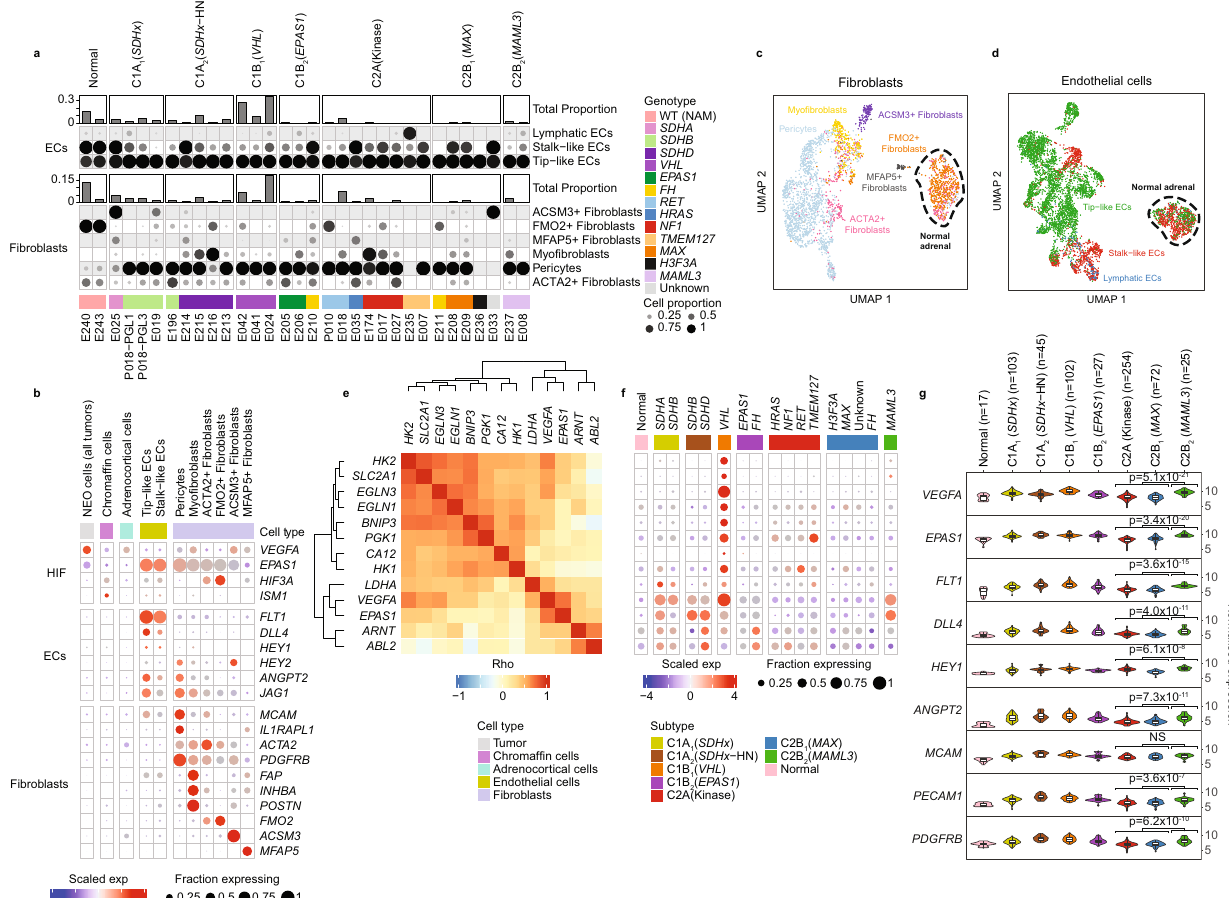
Fig.3|AnalysisofECand fi broblastcellsinPCPGandNAMtissues.a Supervised classi fi cation and enumeration of fi broblast and EC cells in PCPG. Proportions of fi broblastsandECswithineachsample(toppanel)andthefunctionalsubtypesthat make up each major cell type (bottom panels). b Dot plot of the DE cell type/ pathway marker genes of interest expressed in each functional cell subset. Top ranked DE genes contrasting fi broblasts and ECs from tumor and NAM tissues, respectively, in addition to pro-angiogenesis genes EPAS1 , VEGFA and the anti- angiogenesis genes ISM1 , HIF3A found DE between NEO and normal chromaf fi n cells from NAM tissues. Dot plot shows expression from nuclei combined from multiple tumors according to cell type as well as NAM tissues. Chromaf fi n cells shown are from NAM tissues only. c , d UMAP reclustering of c fi broblasts (nCells=2901) and d ECs (nCells=5430) from all tumor and normal samples ana- lyzed by snRNA-seq. Nuclei are colored according to cell subtype classi fi cation.